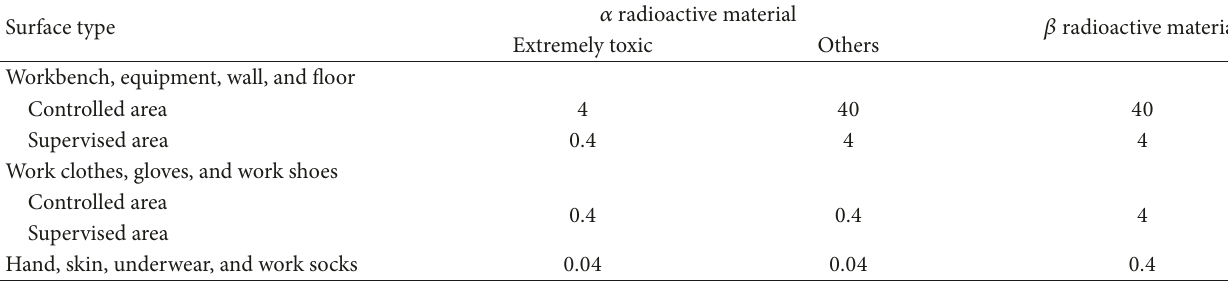
Table 2: Level of radioactive pollution control (Bq/cm 2